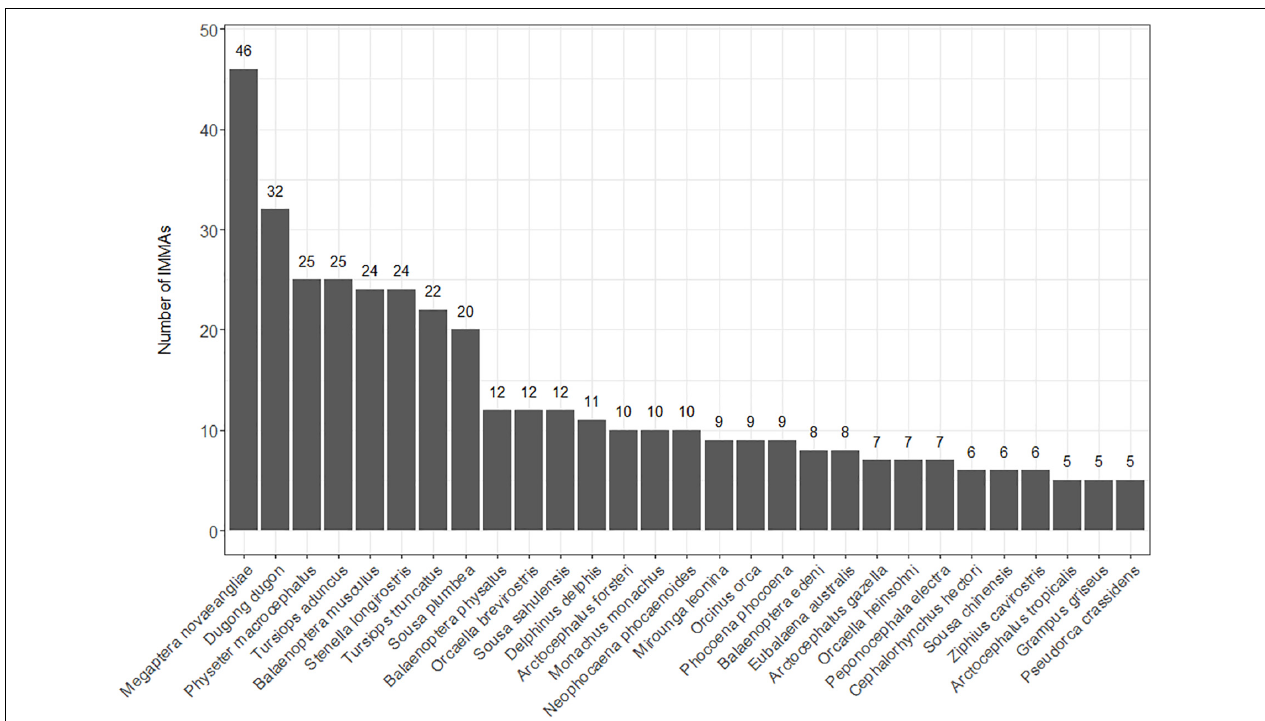
FIGURE 2 | Marine mammal species most frequently used as qualifying species in identification of the 173 IMMAs identified by the Marine Mammal Protected Areas Task Force as of December 2021.